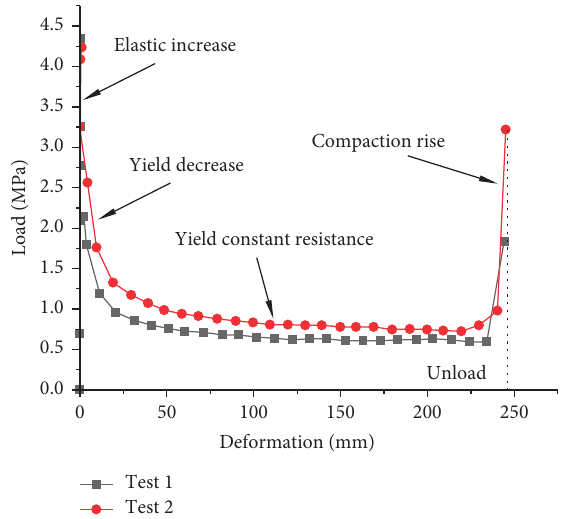
Figure 5: Typical loading-deformation curves of SRLD